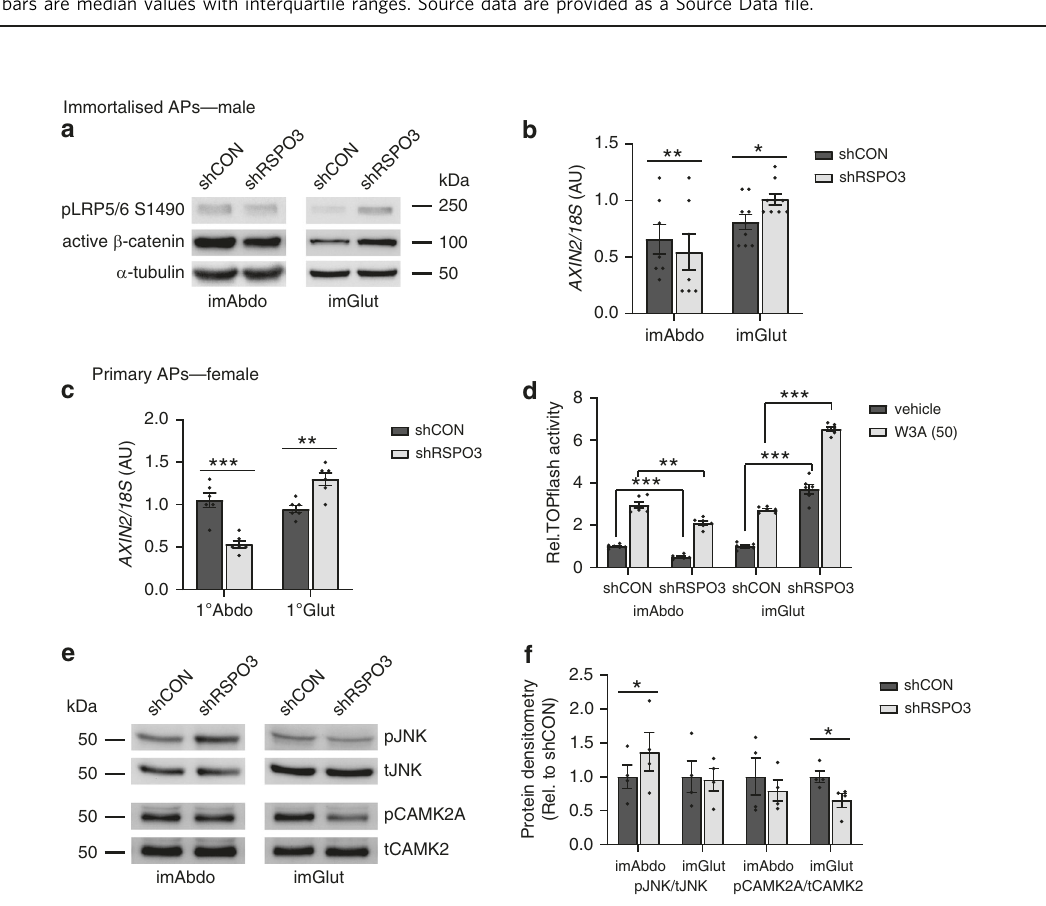
Fig. 4 Effects of doxycycline-induced RSPO3- KD on lipolysis, glucose uptake, and gene expression changes in in vitro differentiated DFAT cells. a Light microscopy of abdominal and gluteal DFAT stable cell lines after 14 days adipogenic differentiation. Scale bar = 100 μ m. b , c Expression of RSPO3 in DFAT stable cell lines at day 15 of adipogenic differentiation following ~ 48-h treatment with 0.05 µ g ml − 1 doxycycline versus vehicle in hormone-free basal media ( n = 5 experiments). d , e Insulin-stimulated glucose uptake in DFAT cells relative to basal glucose uptake following ~ 48-h treatment with 0.05 µ g ml − 1 doxycycline or vehicle in hormone-free basal media ( n = 12, from four independent experiments). f , g Isoproterenol-stimulated glycerol release in DFAT cells relative to basal glycerol release following ~ 48-h treatment with 0.05 μ g ml − 1 doxycycline or vehicle ( n = 12, from four independent experiments). b – g Histogram data are means ± s.e.m. * p < 0.05, ** p < 0.01. Statistical signi fi cance was assessed by two-tailed paired ( b , c ) and unpaired ( d – g ) Student ’ s t -test comparing doxycycline versus vehicle treatment. h , i Transcriptional pro fi ling of in vitro differentiated abdominal and gluteal DFAT cells following 48-h doxycycline-induced RSPO3 -KD. h Number of differentially expressed (DE) genes. FDR p < 0.05. i Gene-set enrichment analysis results of DE genes in gluteal DFAT dox-induced RSPO3 -KD cells showing the top 10 GO biological processes. j , k Effect of doxycycline-induced RSPO3 -KD